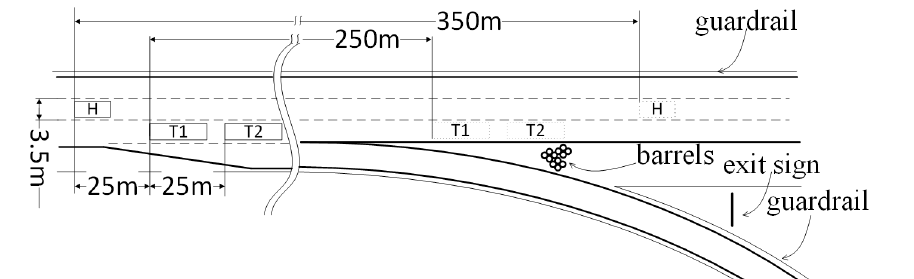
Figure 1. Schematics of the scenario modeled in the environment (H—host vehicle; T1, T2—target vehicles. Solid line indicates initial and dotted final positions).